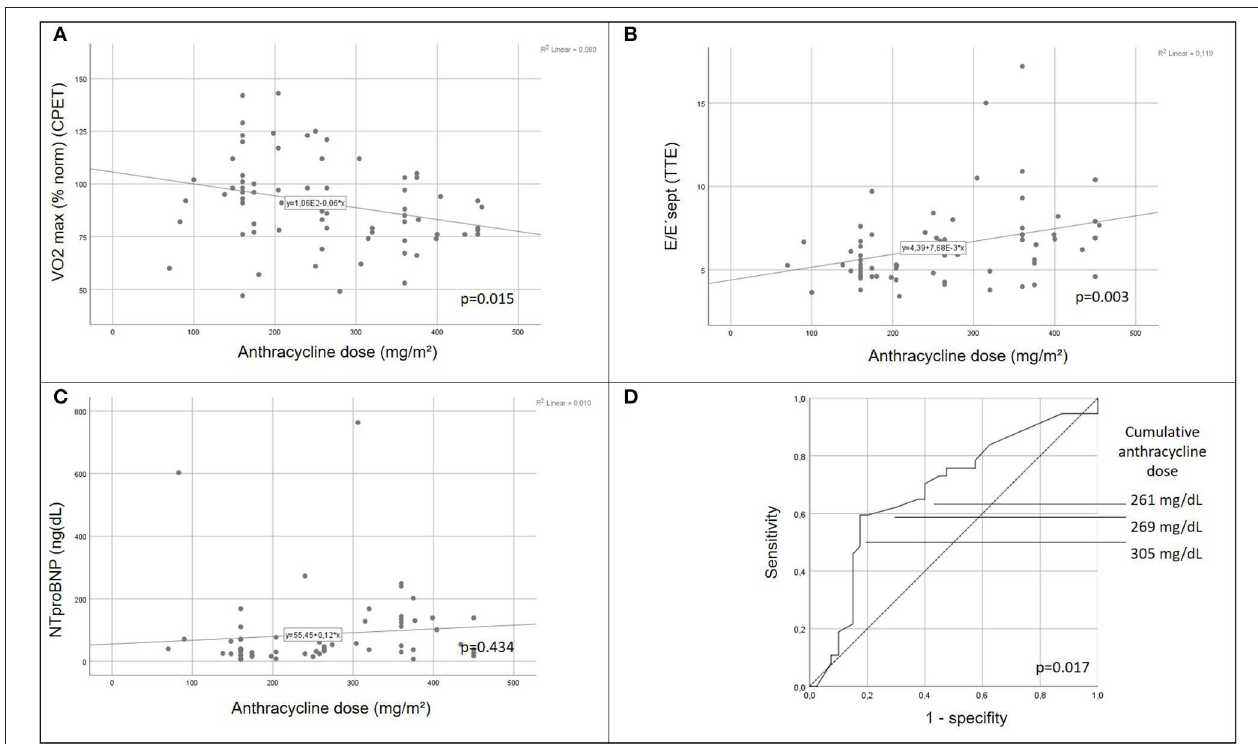
FIGURE 2 | Correlation of cardiomyopathic changes with anthracycline dose. Peak respirator oxygen uptake on cardiopulmonary exercise testing (A) decreases and septal mitral valve E/E’ ratio (B) increases significantly with increasing cumulative anthracycline dose ( p = 0.015 and p = 0.003, respectively, pearson chi square). Trend to increased NTproBNP values with increasing cumulative anthracycline dose (C) . Receiver operating characteristic (ROC) curve illustrating the ability of cumulative anthracycline dose predicting any cardiovascular abnormality (decreased exercise capacity, increased NTproBNP level, or abnormal tissue Doppler septal E/E’ratio) on follow-up (D) . CPET, cardiopulmonary exercise testing; VO 2 max (% norm), peak respiratory oxygen uptake in % predicted; EF, Ejection Fraction; TTE, transthoracic